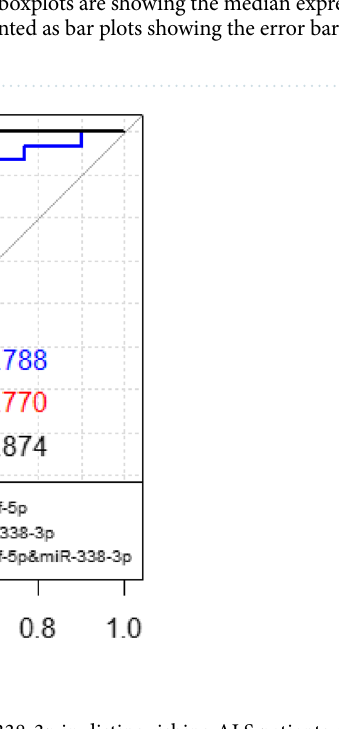
Figure 5. The ROC curve of let-7f-5p and miR-338-3p in distinguishing ALS patients and healthy